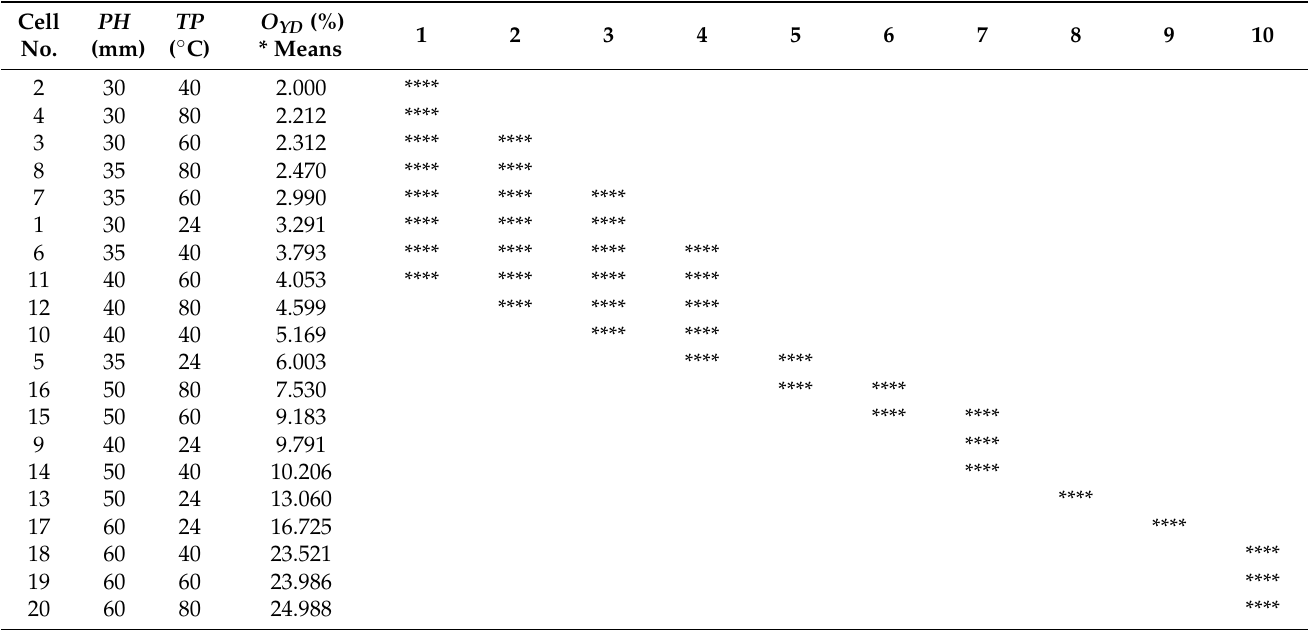
Table 4. Duncan test of homogenous means of the calculated parameter O YD : oil yield (%) for PH and TP